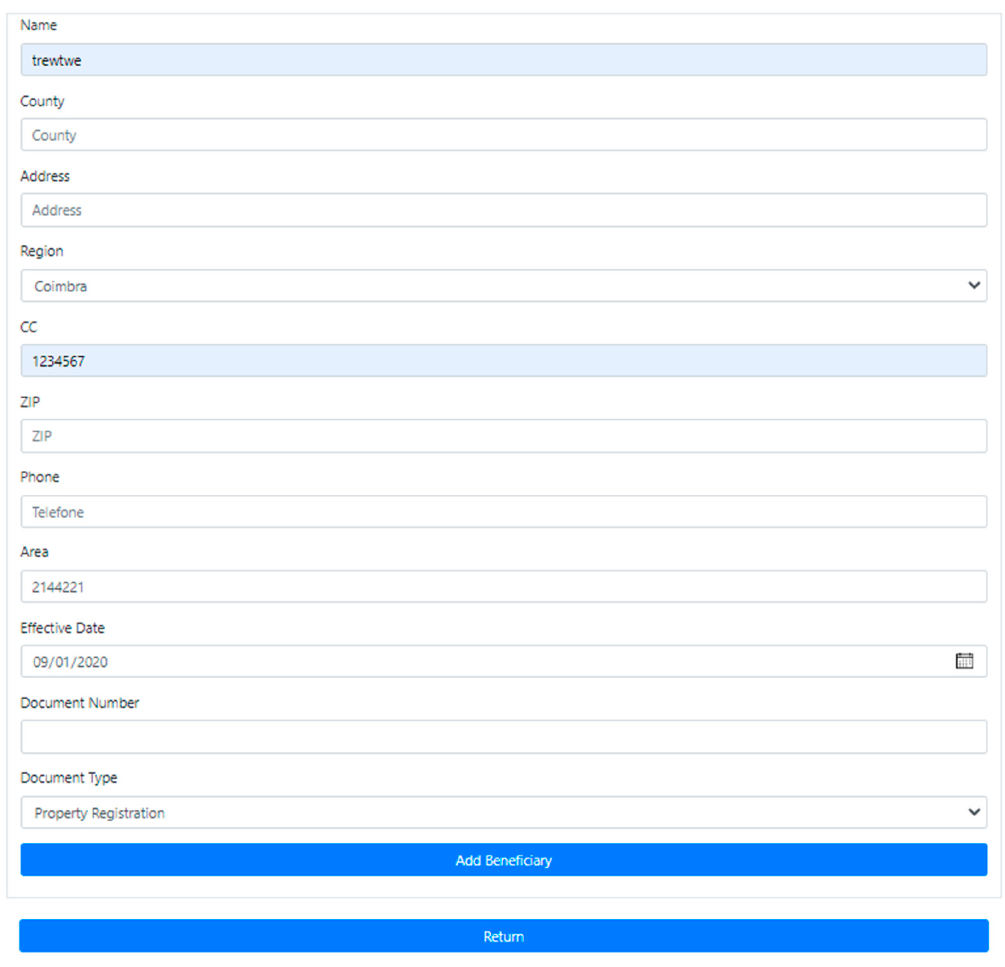
Figure 8. Beneficiary form for adding new beneficiaries.